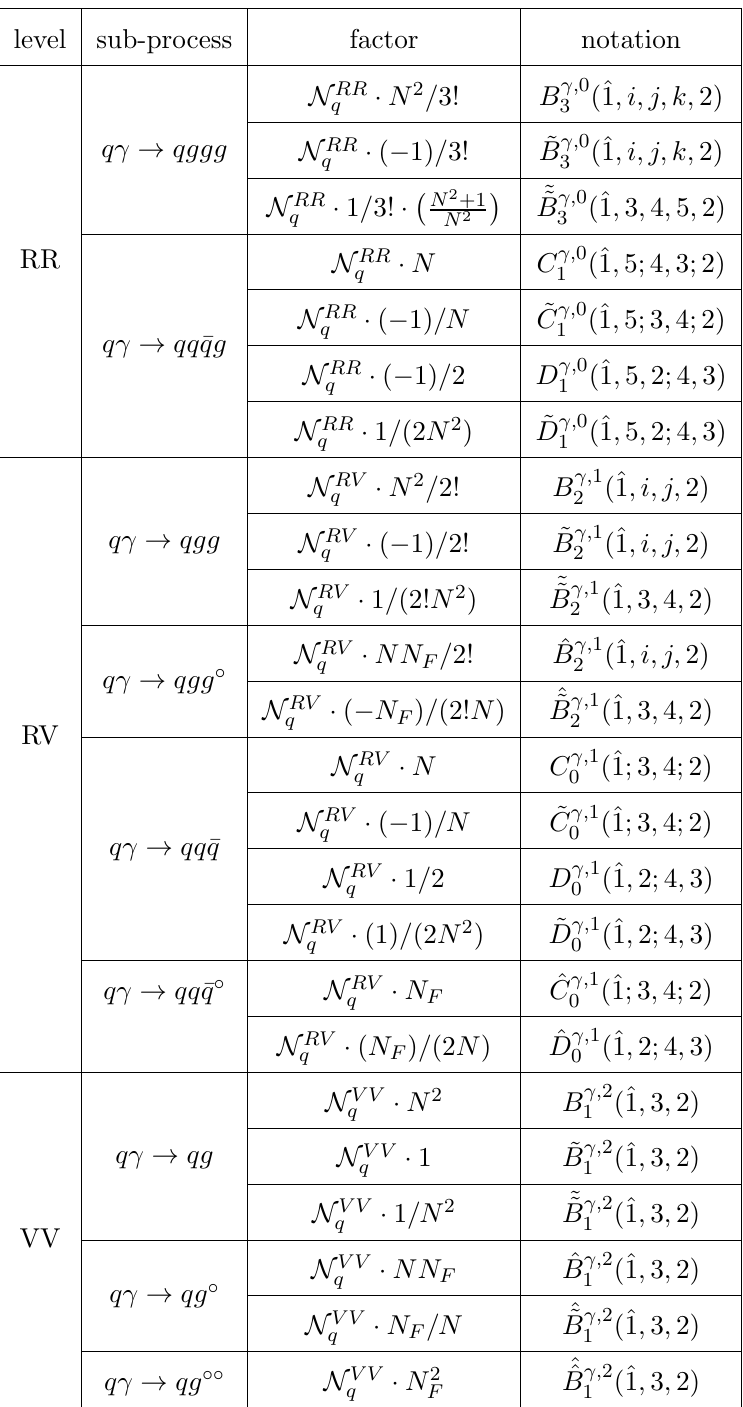
(^1 ; i; j; k; 2) is summed over 3